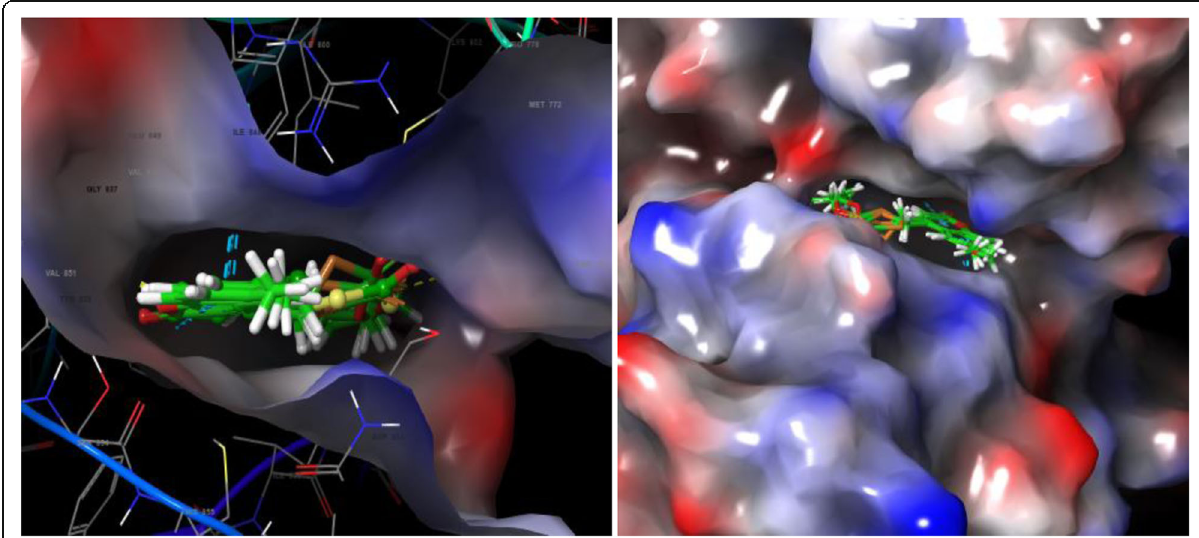
Fig. 2 Both the figures depicts interaction of all compounds with PIK3C α (PDB ID-5DXT) protein active site. Electrostatic potential value plotted surface of PIK3C α with the conformations of ligand compounds and crystal structure of proteins. The carbon atoms PIK3C α are coloured by magenta, cyan, and green, respectively (electropositive charge, blue; electronegative charge, red; and neutral, white)